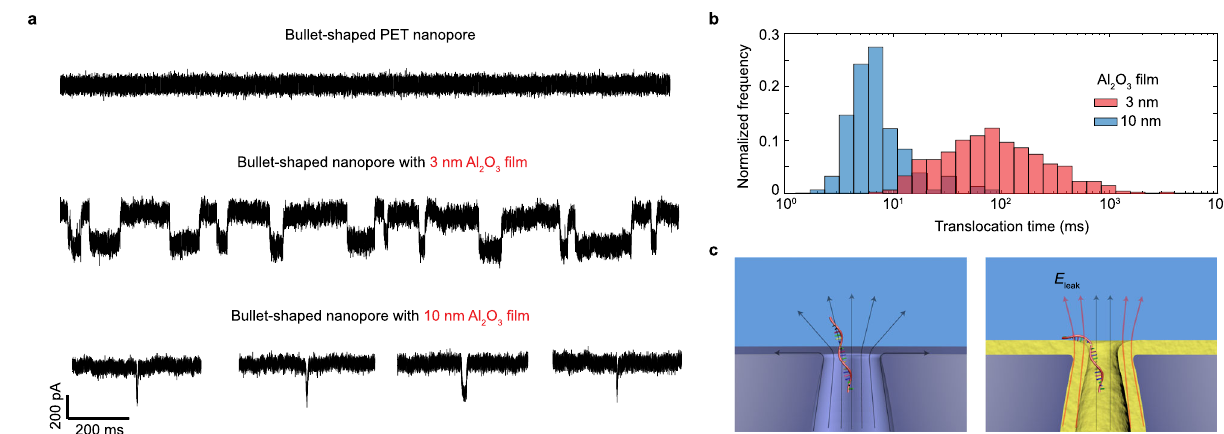
Fig. 2 Slowing down ssDNA translocation speed with electric fi eld leakage. a Representative current traces for 22 nt ssDNA translocation through a bare bullet-shaped PET nanopore without Al 2 O 3 fi lm coating (diameter, 16 nm) and two bullet-shaped nanopores coated with 3 nm or 10 nm Al 2 O 3 fi lm under an applied voltage of 500 mV. Both Al 2 O 3 -coated nanopores have the same fi nal tip diameter (10 nm). All three nanopores have similar bullet-like shapes (half cone angle, 7 ± 2°). Slow translocation of 22 nt ssDNA is observed using nanopores with thin Al 2 O 3 fi lm coating and the average translocation time is a function of fi lm thickness. b Normalized histogram of translocation times for nanopores with 3 nm or 10 nm Al 2 O 3 fi lm. Average translocation time: 3 nm Al 2 O 3 fi lm, 159 ms ( n = 492 events); 10 nm, 13 ms ( n = 46 events). c Schematic showing the dominant tangential electric fi eld at the bare PET nanopore edge results in a fast translocation of 22 nt ssDNA (left) while the normal leakage fi eld at the Al 2 O 3 -coated nanopore edge traps the ssDNA and thus reduces its mobility.